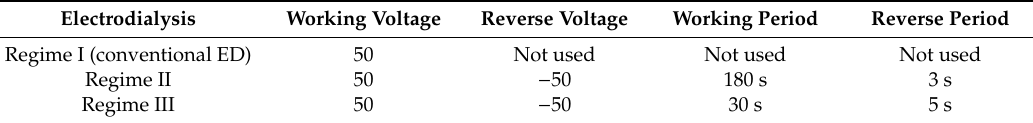
Table 5. The ED regimes which were applied for the desalination of